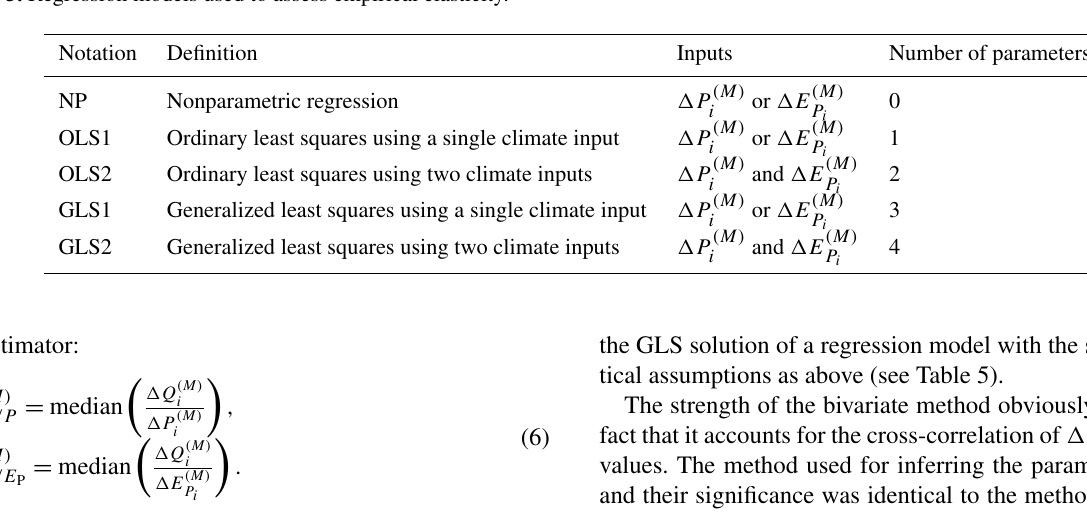
Figure 4. Streamflow elasticity graphs for an empirical (data-based) assessment for the Brèze catchment at Meyrueis (code: O3165010): (a) (cid:49)Q vs. (cid:49)P , (b) (cid:49)Q vs. (cid:49)E P , and (c) (cid:49)Q (color-coded) vs. (cid:49)P and (cid:49)E P . Table 3. Regression models used to assess empirical